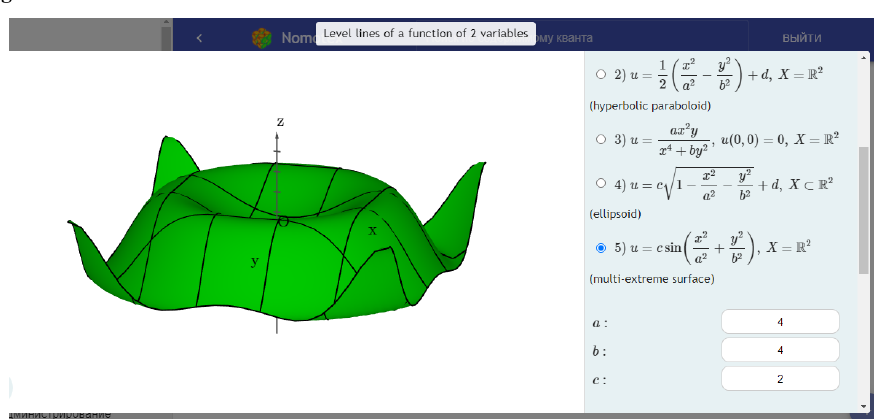
Fig. 2. An example of a "Mathematical Example" in a Quantum of Knowledge.